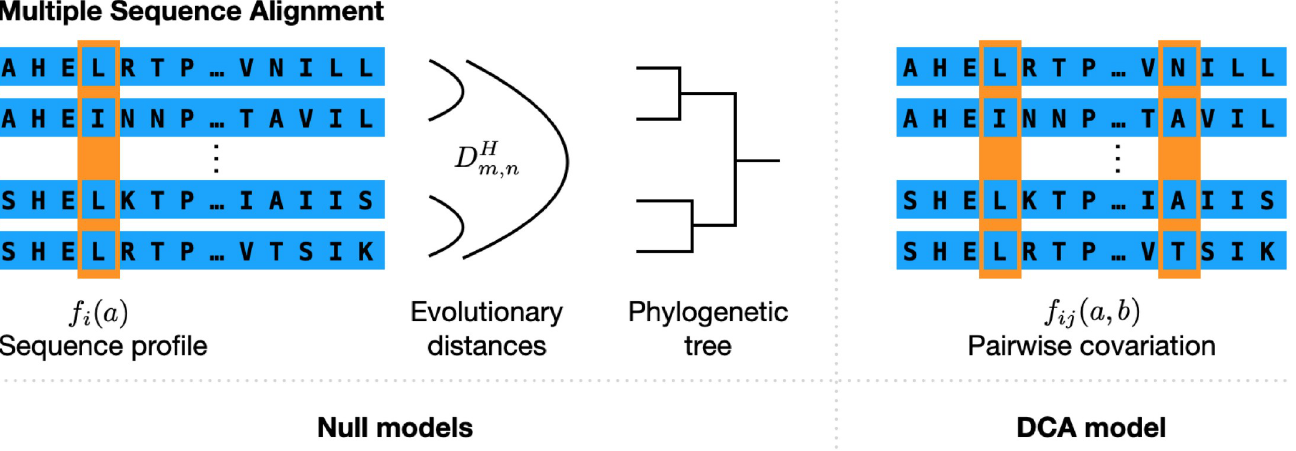
Fig 1. Schematic representation of the information used by DCA and the null models. MSA contain several types of information about the sequence variability. The sequence profile and residue covariation describe the statistics of individual MSA columns and column pairs, both are used in DCA. However, the MSA j 1 � m < n � M g of Hamming distances between sequences, or by the (inferred) contains also phylogenetic information, here represented by the matrix f D H mn phylogenetic tree. The different null models use the profile and phylogenetic information, but no residue covariation.